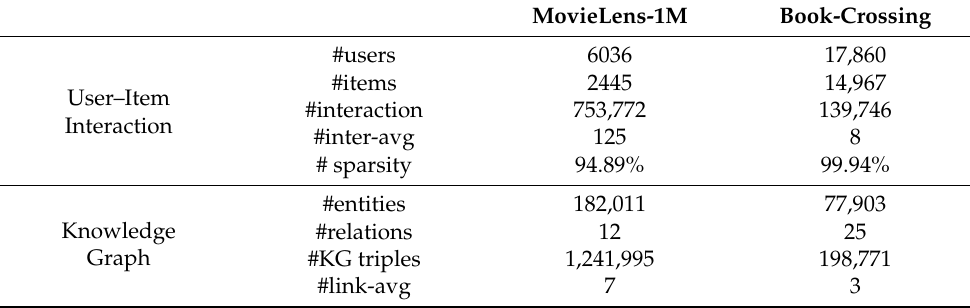
Table 1. Statistics of two datasets: MovieLens-1M and